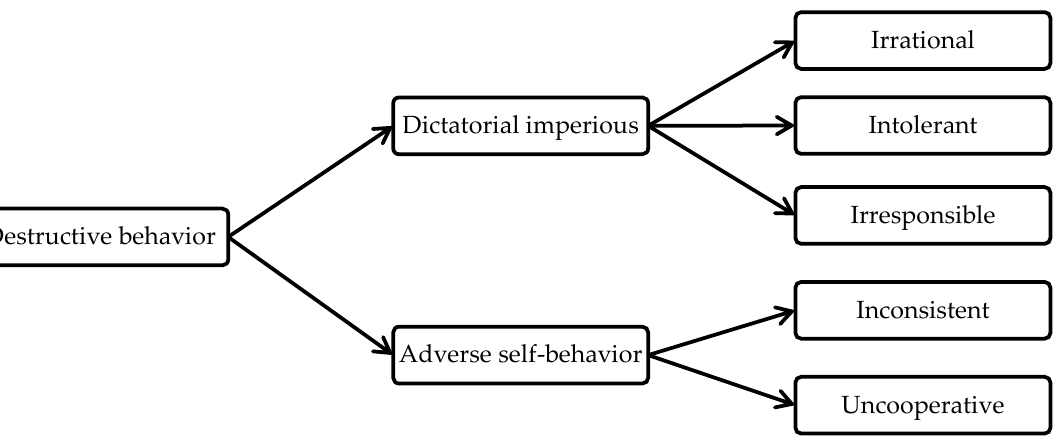
Figure 3. Destructive leadership behaviors in BIM-based construction projects.